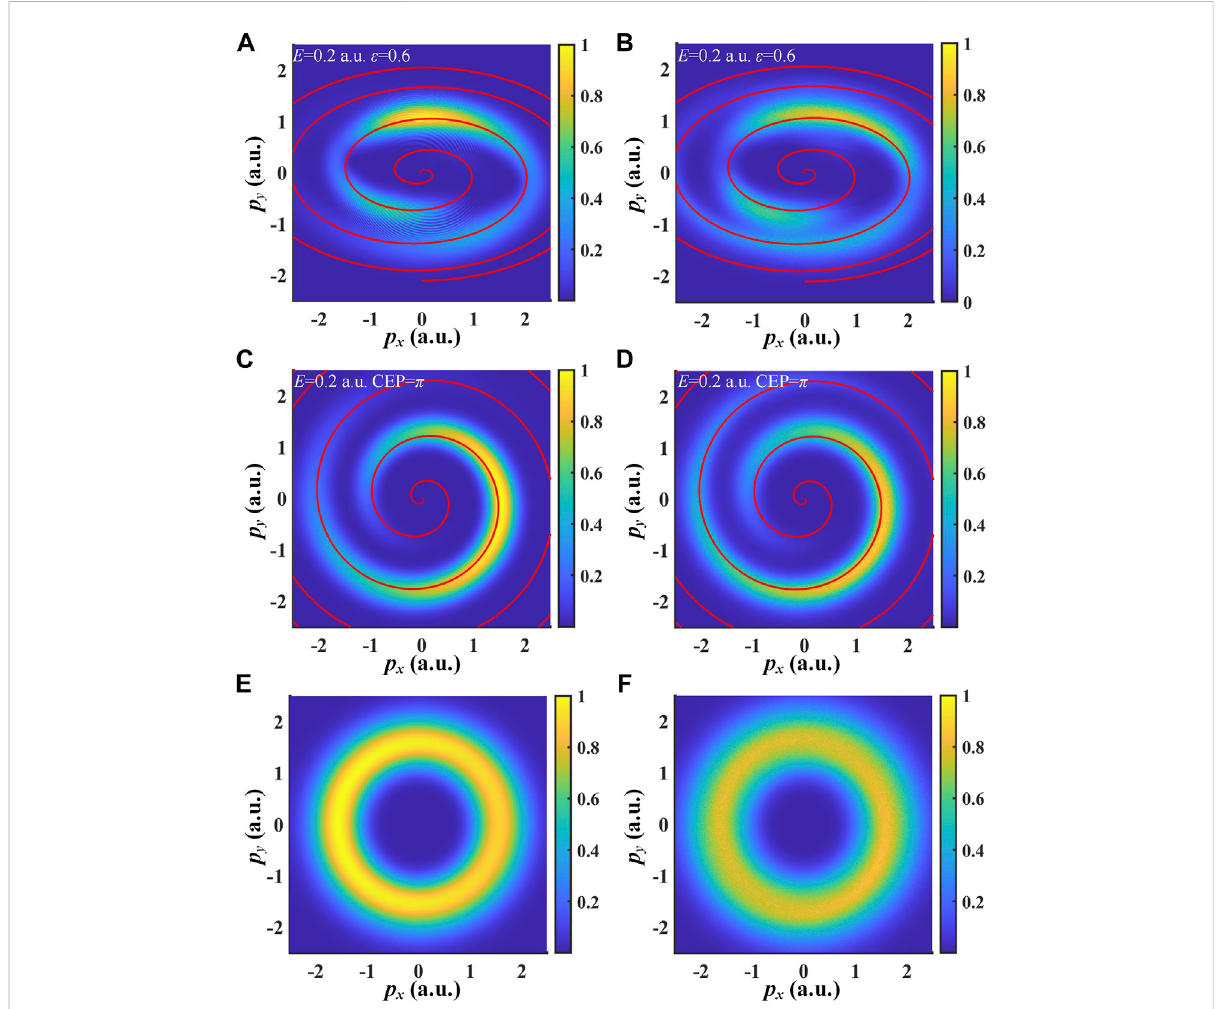
FIGURE 5 The calculated photoelectron momentum distributions for different ellipticities and CEPs. The left column is calculated by TDSE and the right column is calculated by SCM. (A,B) E (cid:1) 0 . 2 a.u., ε (cid:1) 0 . 6, CEP (cid:1) 0; (C,D) E (cid:1) 0 . 2 a.u., ε (cid:1) 1, CEP (cid:1) π ; (E,F) the superposition of photoelectron spectra with different